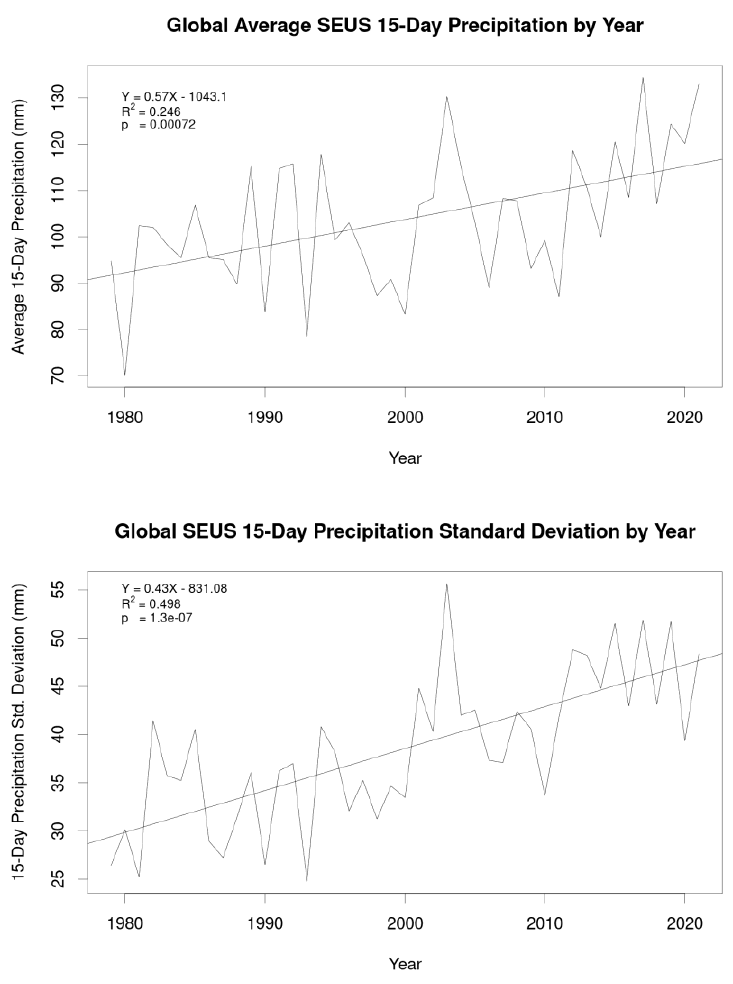
Figure 3. Annual average ( top panel) and standard deviation ( bottom panel) 15-day moving sum precipitation for the full SEUS study domain. Information on the linear fit for each positive trend is provided in the respective top left corner of the panel.